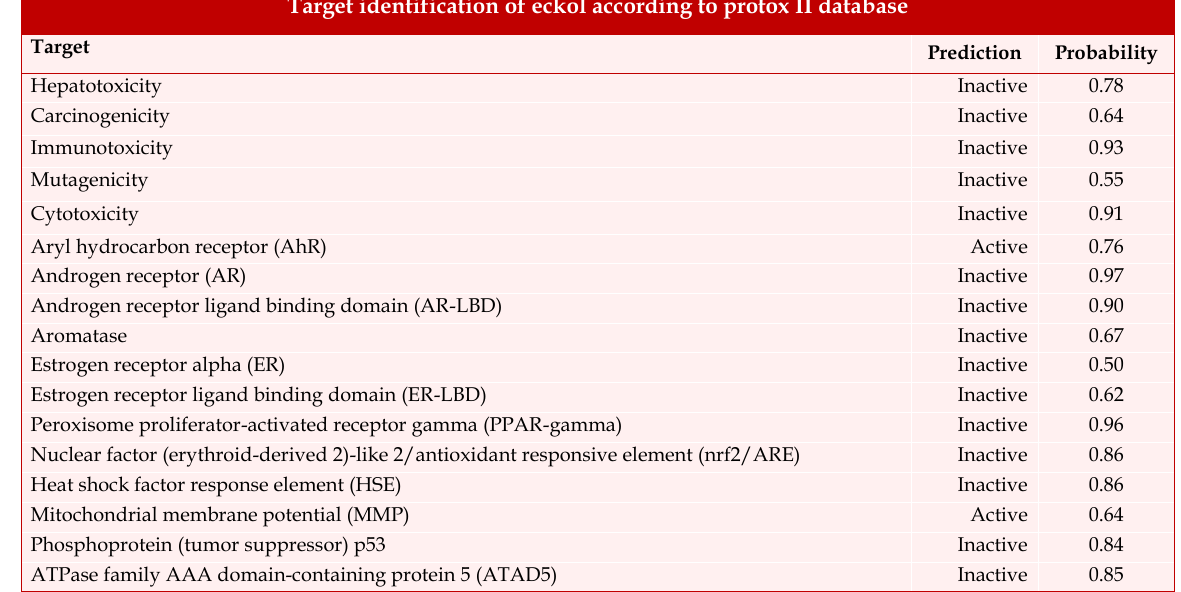
Target identification of eckol according to protox II